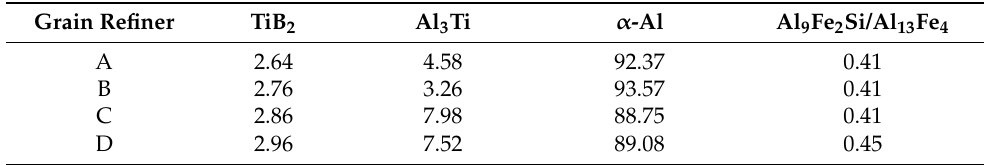
Figure 1. Mass fractions of all solids formed during solidification of investigated grain refiners. The simulation is based on the Scheil model. Table 2. Mass fraction of equilibrium phases at room temperature in wt.%.